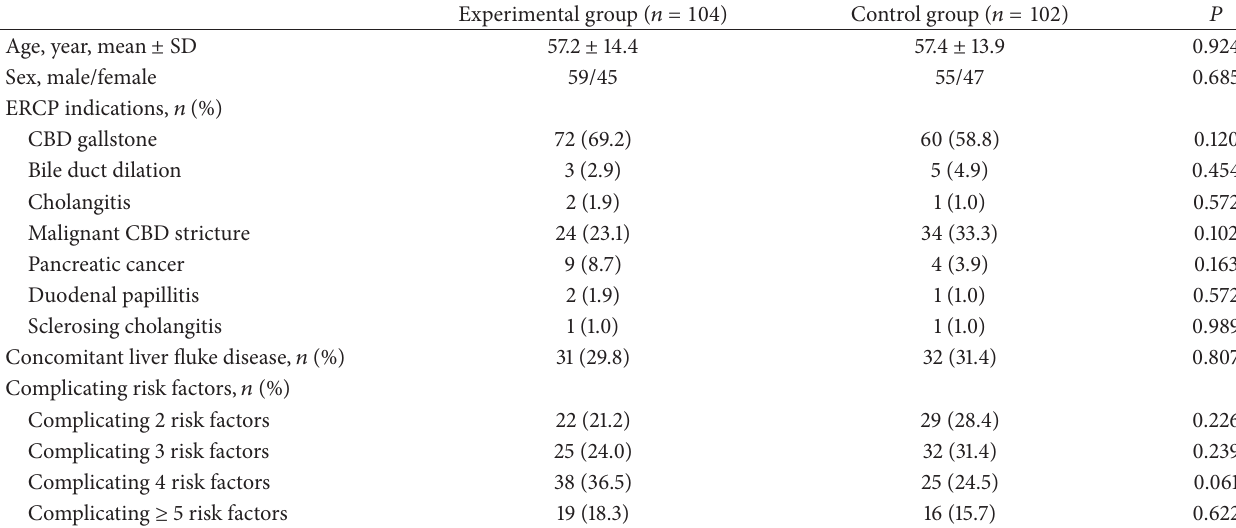
Table 1: Baseline demographic and clinical characteristics of patients.